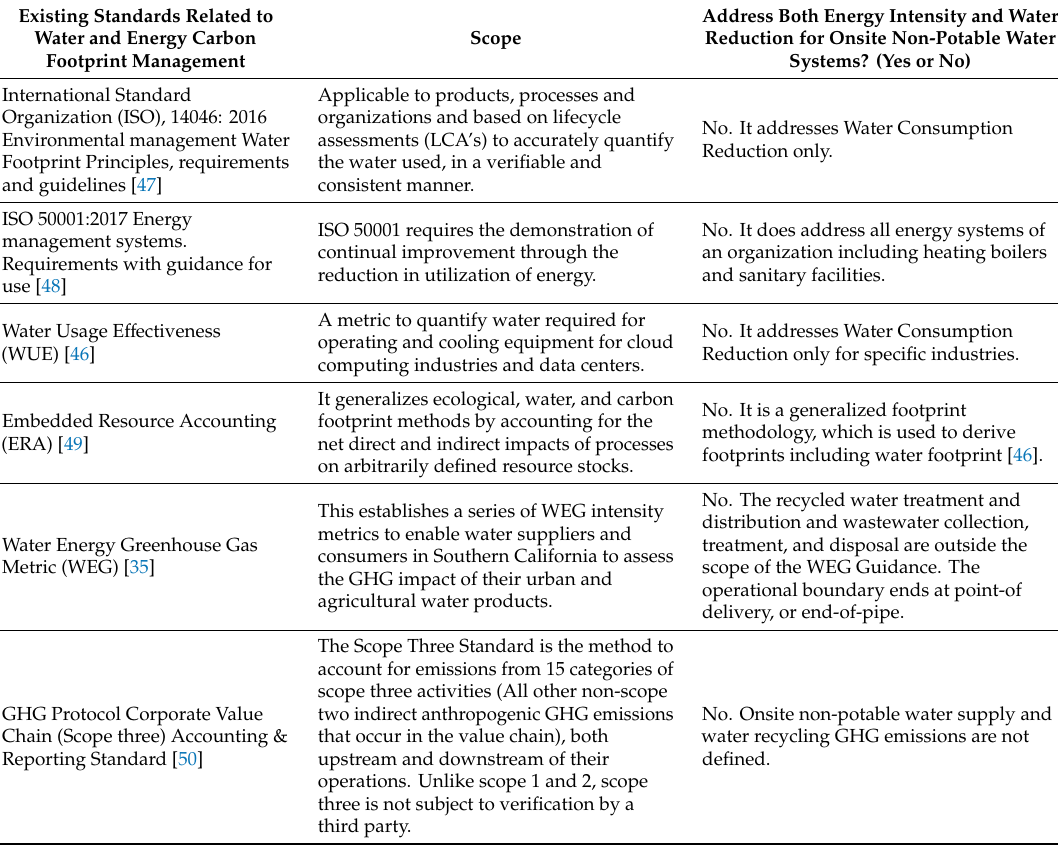
Table 3. Onsite non-potable water systems for the greenhouse gas (GHG) benchmarking knowledge